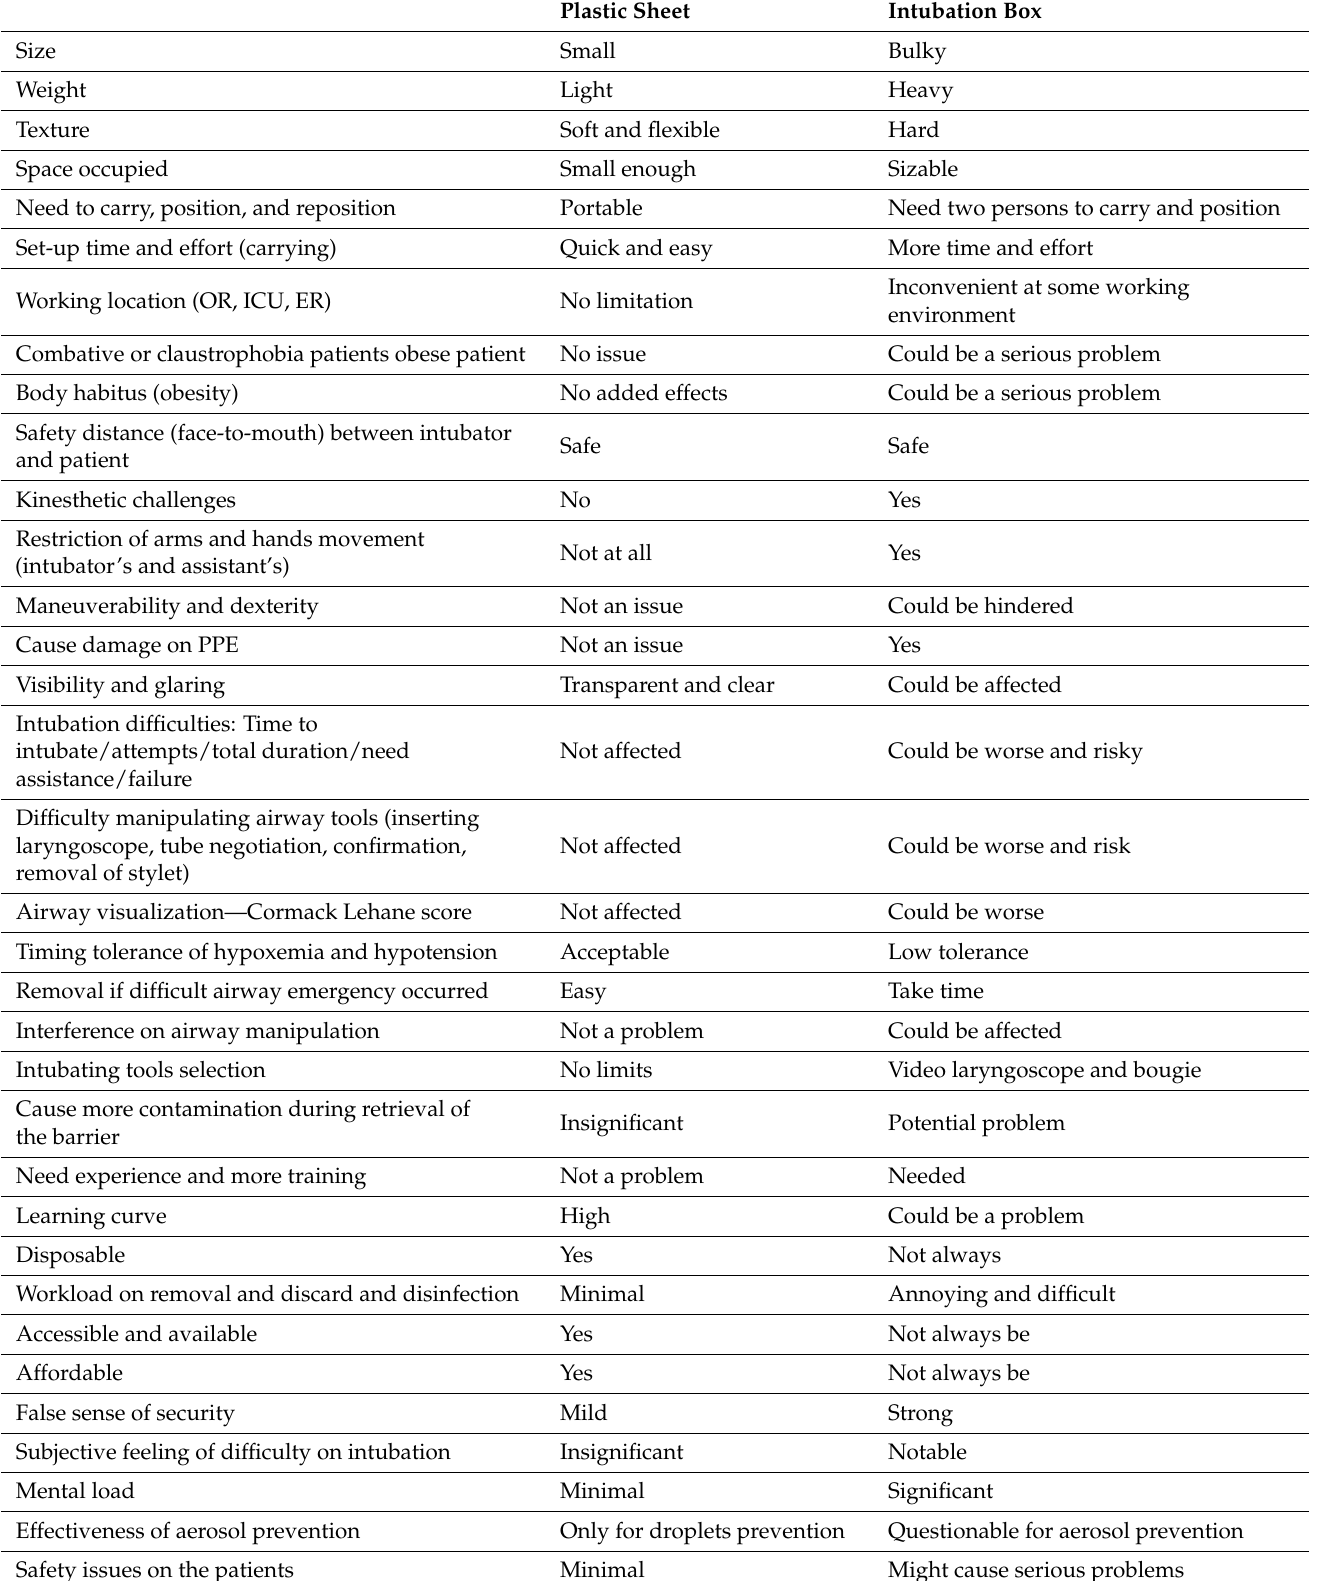
Table 2. Comparison between plastic sheet and intubation